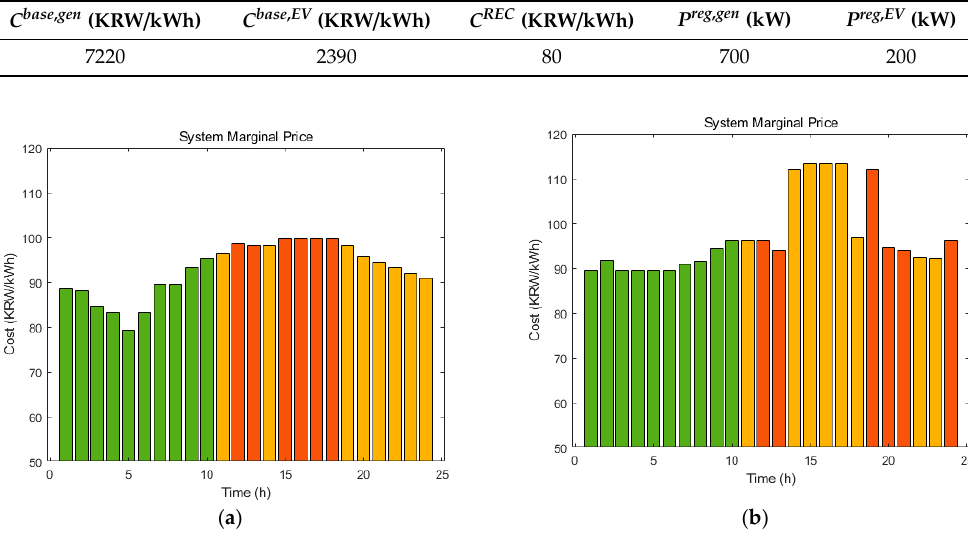
Table 1. Electricity charge data.